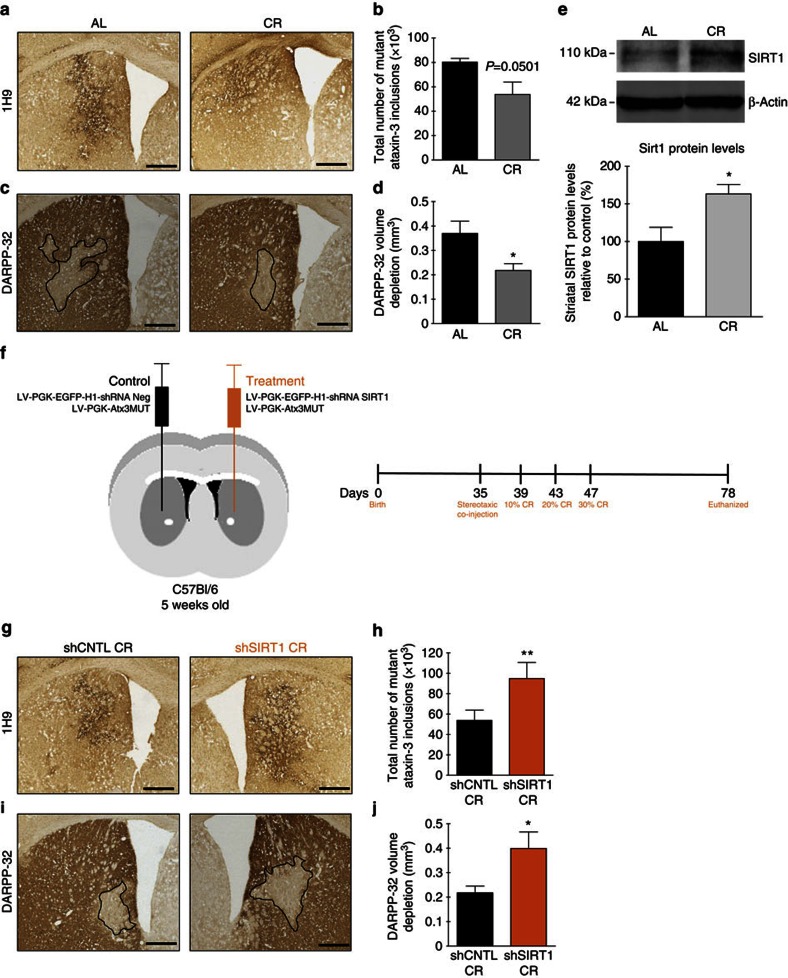
CR alleviates MJD neuropathology by the SIRT1 pathway in striatal lentiviral model of MJD.(a) Mutant ataxin-3 aggregates counting, quantified in b, showed that CR decreased mutant ataxin-3 inclusions in the striatum. Scale bar, 500 μm. (c) A higher DARPP-32 volume depletion, quantified in d, was observed in animals in an AL diet, compared with calorie-restricted mice. Scale bar, 500 μm. (e) Immunoblotting demonstrating that calorie-restricted mice have an increase in the protein levels of SIRT1 in striatum in comparison with AL mice. (f) Schematic representation of the study. Five-week-old C57Bl/6J mice were stereotaxically injected in the striatum. In each hemisphere we injected lentiviral vectors encoding for mutant ataxin-3; in the left hemisphere was co-injected lentiviral vectors encoding for the shRNA control and in the right hemisphere was co-injected lentiviral vectors encoding for the shRNA targeting SIRT1. Four days after the surgeries, animals were divided in two groups. One group of mice was maintained in an AL diet and the other was in a CR diet. (g) Mutant ataxin-3 inclusions counting showed that SIRT1 silencing prevented the decrease in the number of inclusions induced by CR. This was quantified in h. Scale bar, 500 μm. (i) DARPP-32 staining revealed that genetic silencing of SIRT1 in the striatal lentiviral model of MJD induced a blockage of the benefits of CR. This was quantified in j. Scale bar, 500 μm. Data represent mean±s.e.m.; *P<0.05 and **P<0.01 compared with control. (b,d,e) Unpaired Student's t-test. n=5. (h,j) Paired Student's t-test. n=5.